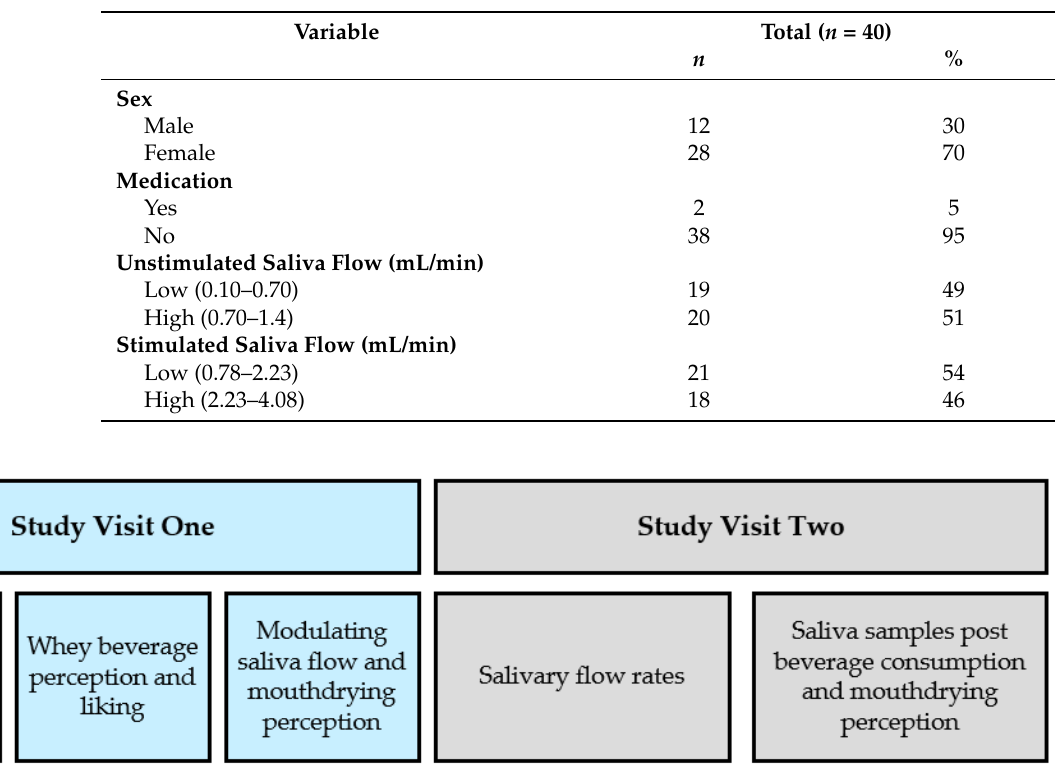
Figure 1. Study Overview (2-AFC: two alternative forced choice).